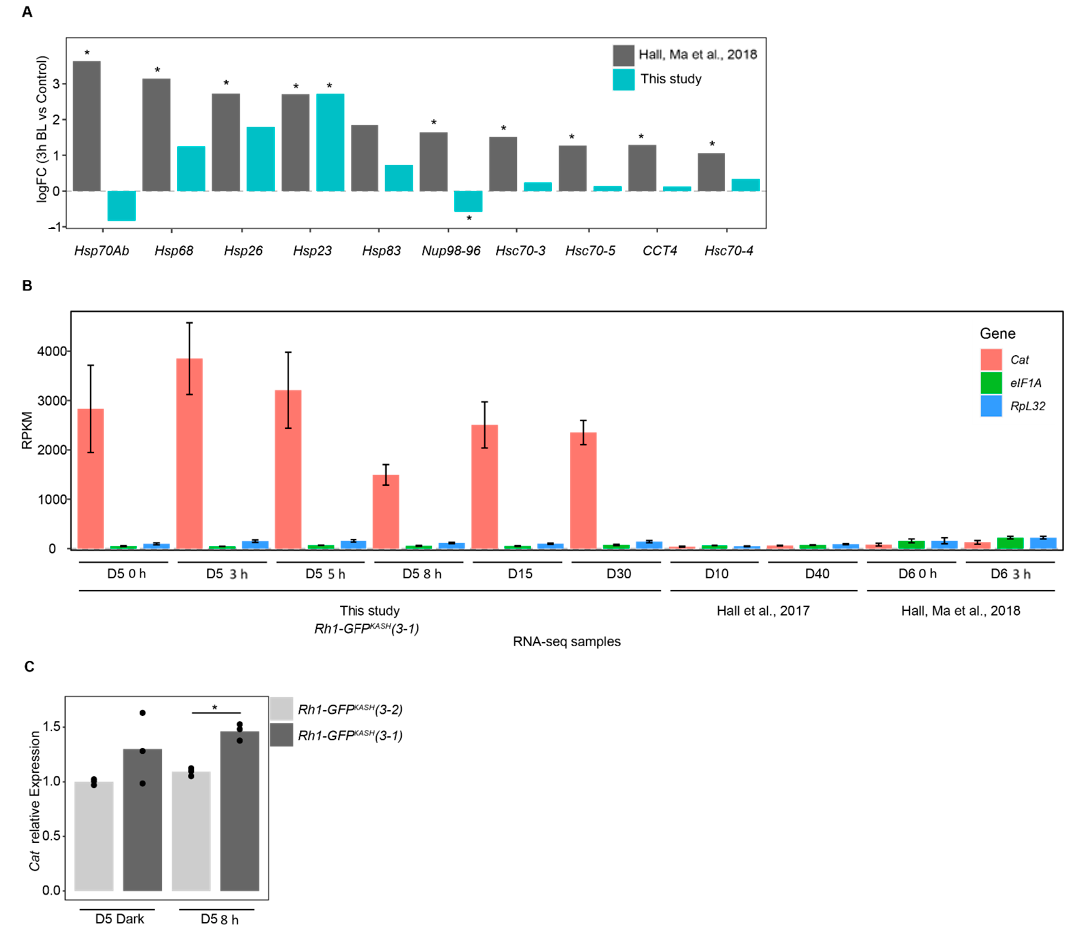
Figure 3. Overexpression of Catalase in Rh1-GFP KASH flies correlates with lower induction of stress-response genes follow- ing blue light exposure. ( A ) log 2 fold-change values for 3 h blue light versus control for the indicated genes in Hall, Ma et al. 2018 versus this study. *, FDR < 0.05. ( B ) Relative expression (RPKM) of the indicated genes in samples from this study relative to Hall, Ma et al. 2018 and Hall et al. 2017. Panels A and B show nuclear transcript levels based on RNA-seq analysis. Age and/or blue light treatment indicated on x axis (D, days; h, blue light exposure time). Bars indicate mean ± SD. ( C ) Bar plots showing qPCR analysis of Catalase mRNA levels from male heads, representing steady-state transcript levels. Bars represent mean expression relative to reference genes with individual replicates overlaid as points. *, p -value < 0.005.